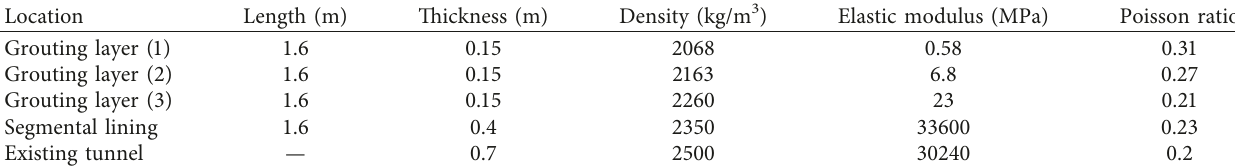
Table 3: Material parameters of various types of